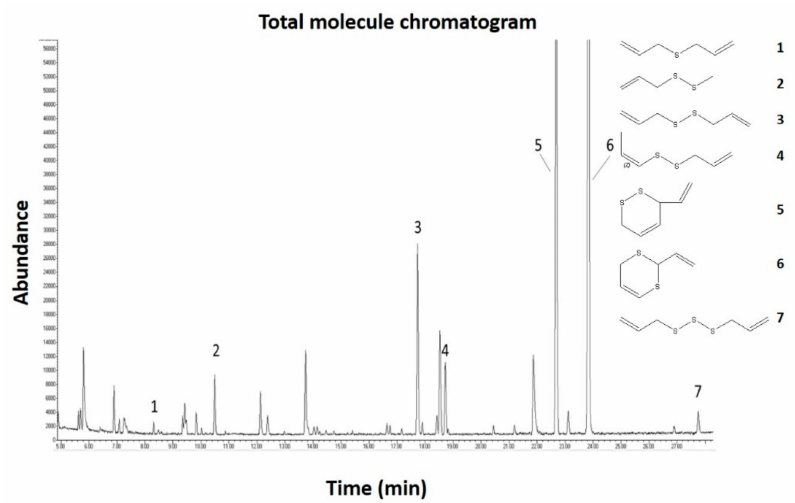
Figure 1. The total molecule chromatogram from gas chromatography mass spectrometric (GC-MS) analysis of the garlic juice. The exact organo-sulfur compounds could be identified and their formula are shown: 1 diallyl sulfide, 2 3-(Methyldisulfanyl)-prop-1-ene, 3 diallyl disulfide, 4 ( Z )-1-(prop-2-enyldisulfanyl)prop-1-en, 5 3-ethenyl-3,6- dihydrodithiine, 6 2-ethenyl-4 H